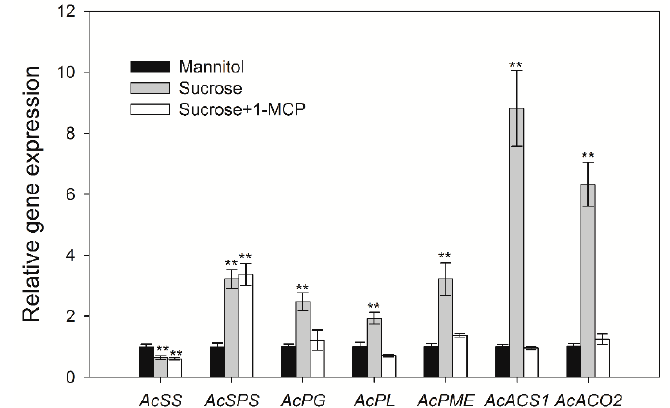
Figure 4. Sucrose-modulated expression of genes involved in fruit ripening or ethylene biosynthesis. Detached kiwifruit were treated with 50 mM sucrose or mannitol for 9 h. To block ethylene signaling, samples were treated with 50 mM sucrose containing 10 mM l-MCP. The data are expressed as the mean ± S.D. The asterisks indicate a significant difference relative to mannitol treatment according to the student’s t -test (** p < 0.01).